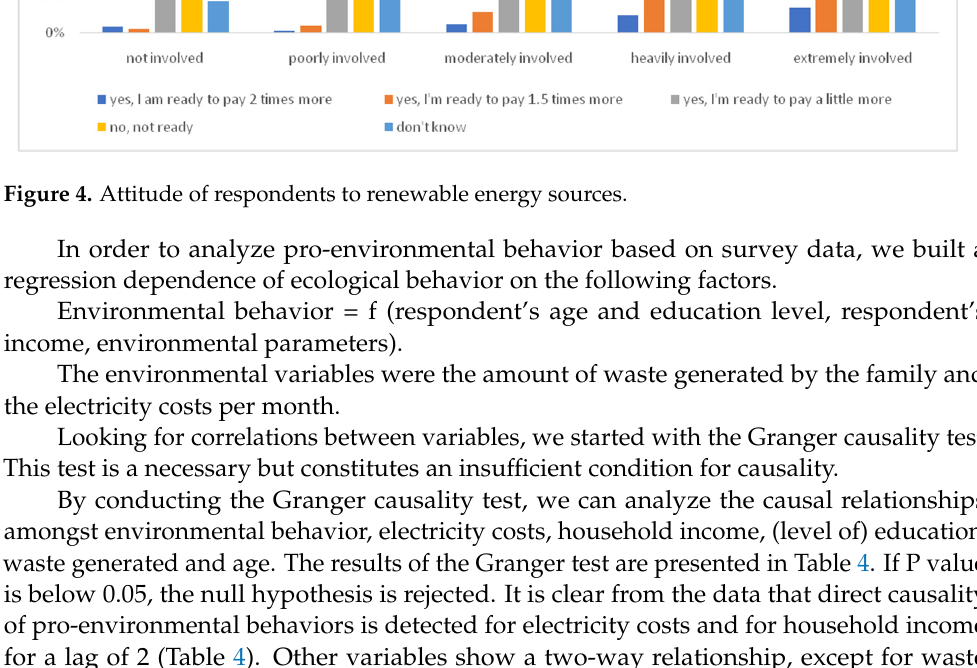
Figure 4. Attitude of respondents to renewable energy sources.